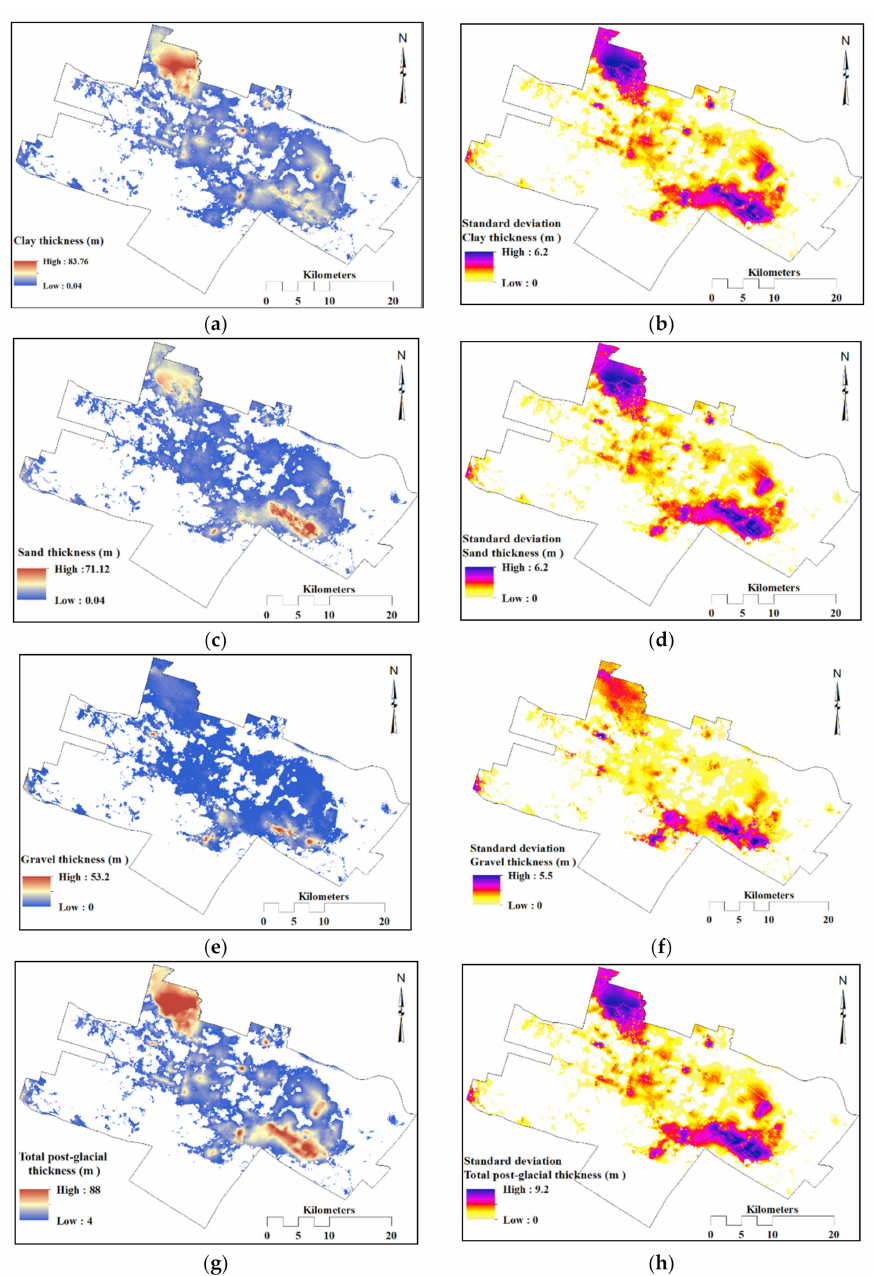
Figure 14. Spatial distribution of the weighted thickness and associated spatial standard deviation ( σ h ) for ( a , b ) clay, ( c , d ) sand, ( e , f ) gravel and ( g , h ) total post-glacial